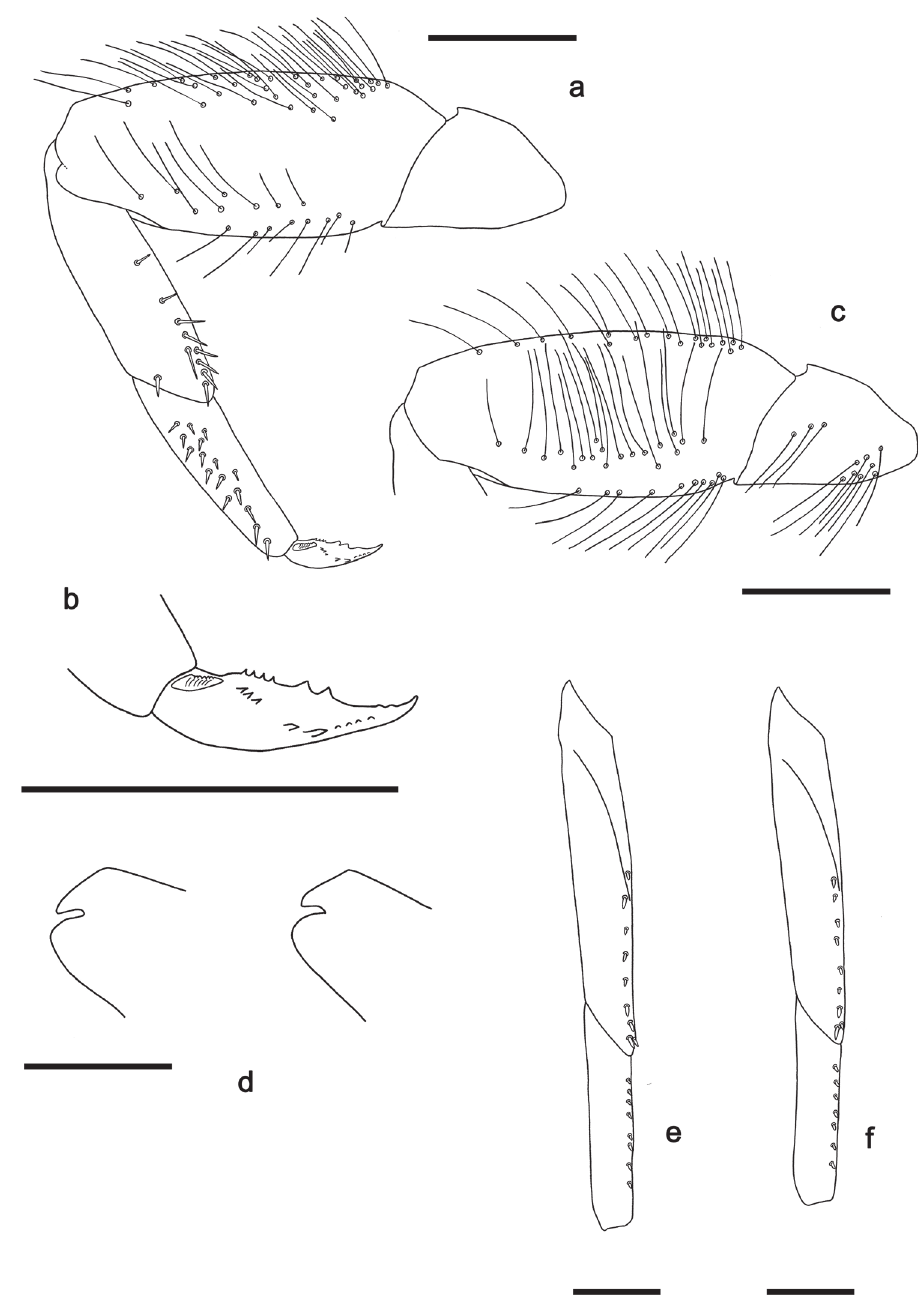
Figure 5. Pedicelliops capillifer gen. et sp. nov., larva morphology a foreleg (anterior view) b fore claw c fore femur and trochanter (posterior view) d apex of middle and hind femur e middle tibia and tarsus f hind tibia and tarsus. Scale bars: 0.2